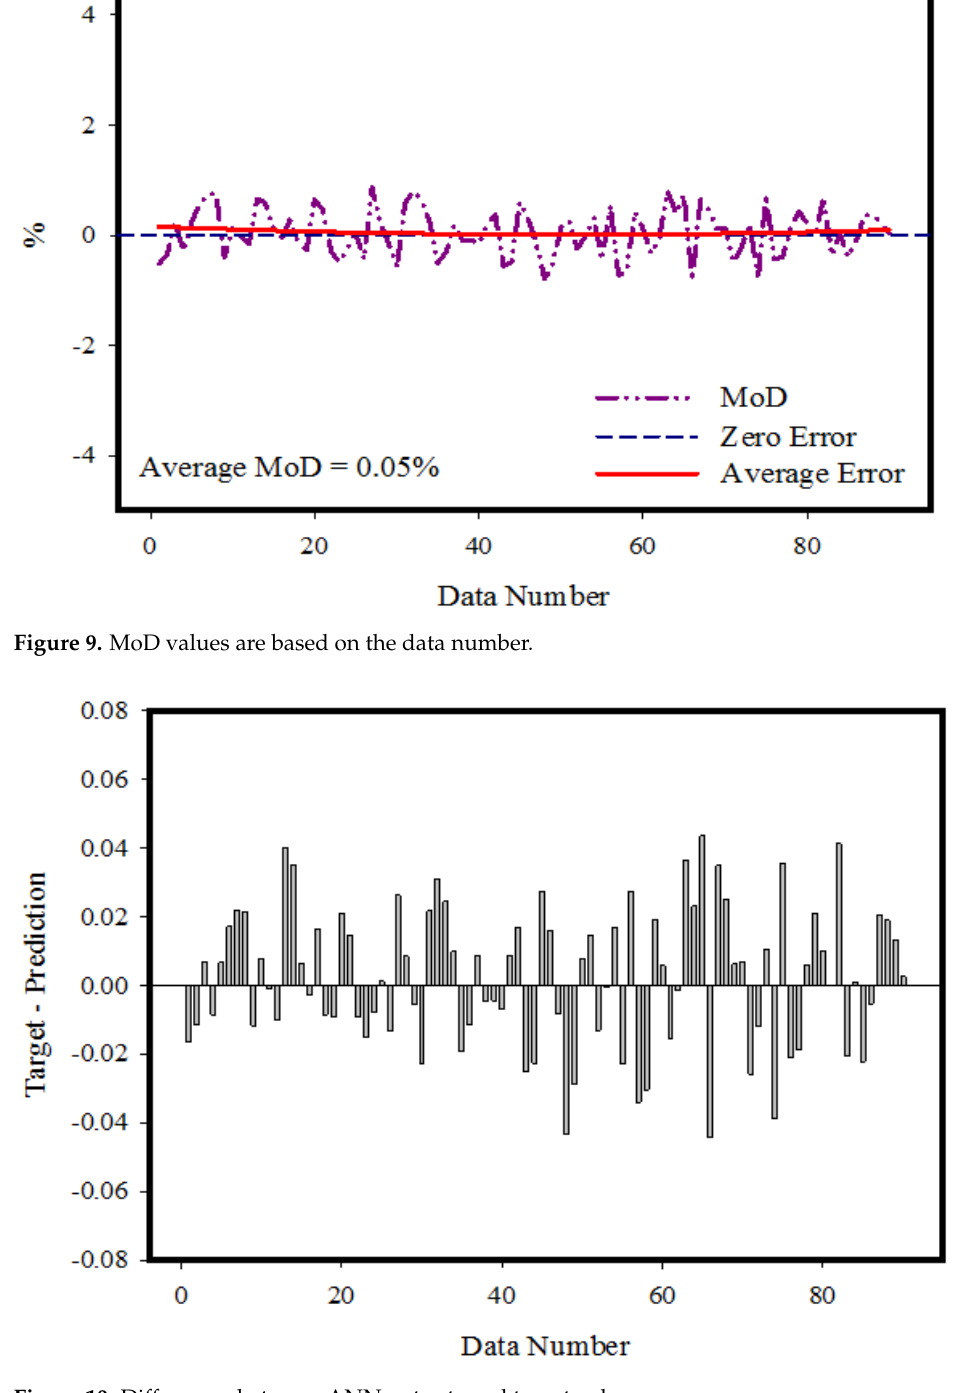
Figure 10. Differences between ANN outputs and target values.